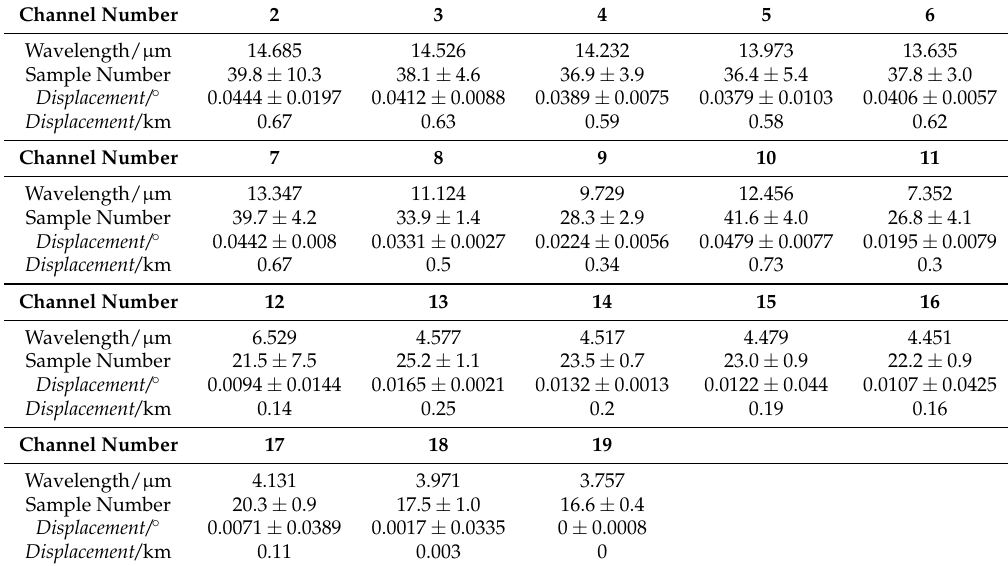
Table 4. Sample number of the smallest distance between the position of the Moon and the center of the DSV for the space calibration line from 2012-03-04 at 5:07 UTC with HIRS/4 on NOAA-19. The differences in sample number correspond to differences in the pointing direction of the different channels in the along-track direction. The numbers given in the fourth and fifth row are relative to the position of the Moon in channel 19, and they are positive, if the pointing direction of a channel is displaced in the flight